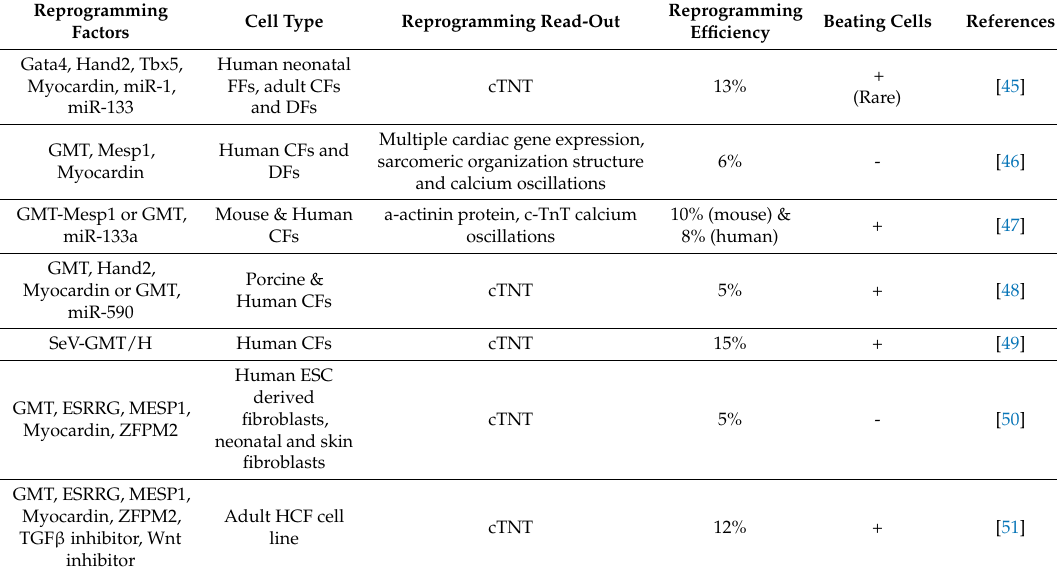
FFs: Foreskin fibroblasts; CFs: Cardiac Fibroblasts; DFs: Dermal Fibroblasts; SeV: Sendai virus; ESC embryonic stem